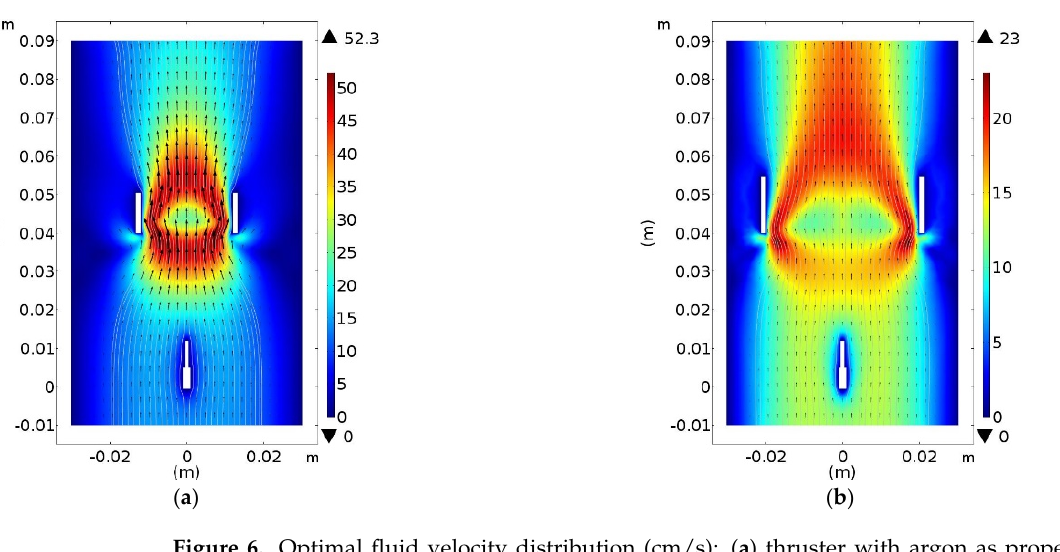
Figure 6. Optimal fluid velocity distribution (cm/s): ( a ) thruster with argon as propellant gas; ( b ) thruster with xenon as propellant gas. Notice the different scales necessary to reinforce the contrast in both pictures.